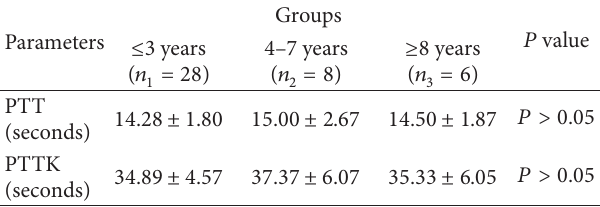
Table 2: Comparison of the prothrombin time test (PTT) and partialthromboplastintimetestkaolin(PTTK)basedondurationof illness of hypertensive patients attending the University of Calabar Teaching